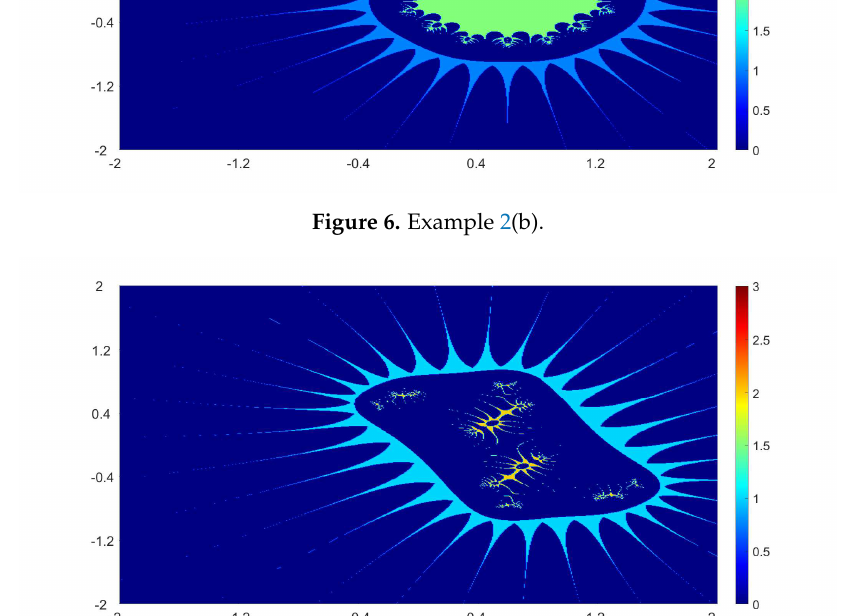
Figure 6. Example 2(b).